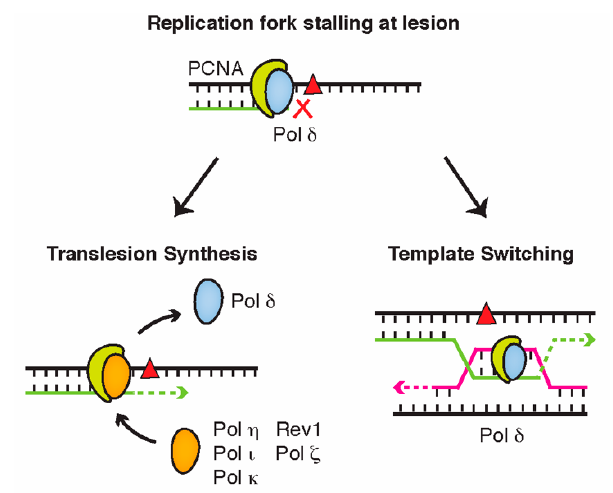
Figure 3. DNA damage bypass allows cells to evade lesions that stall replicative polymerases. During translesion synthesis, the replicative polymerase is replaced by a specialized translesion polymerase that can replicate past the lesion. In template switching, the replisome bypasses the lesion by temporarily replicating the nascent strand of a sister chromatid.